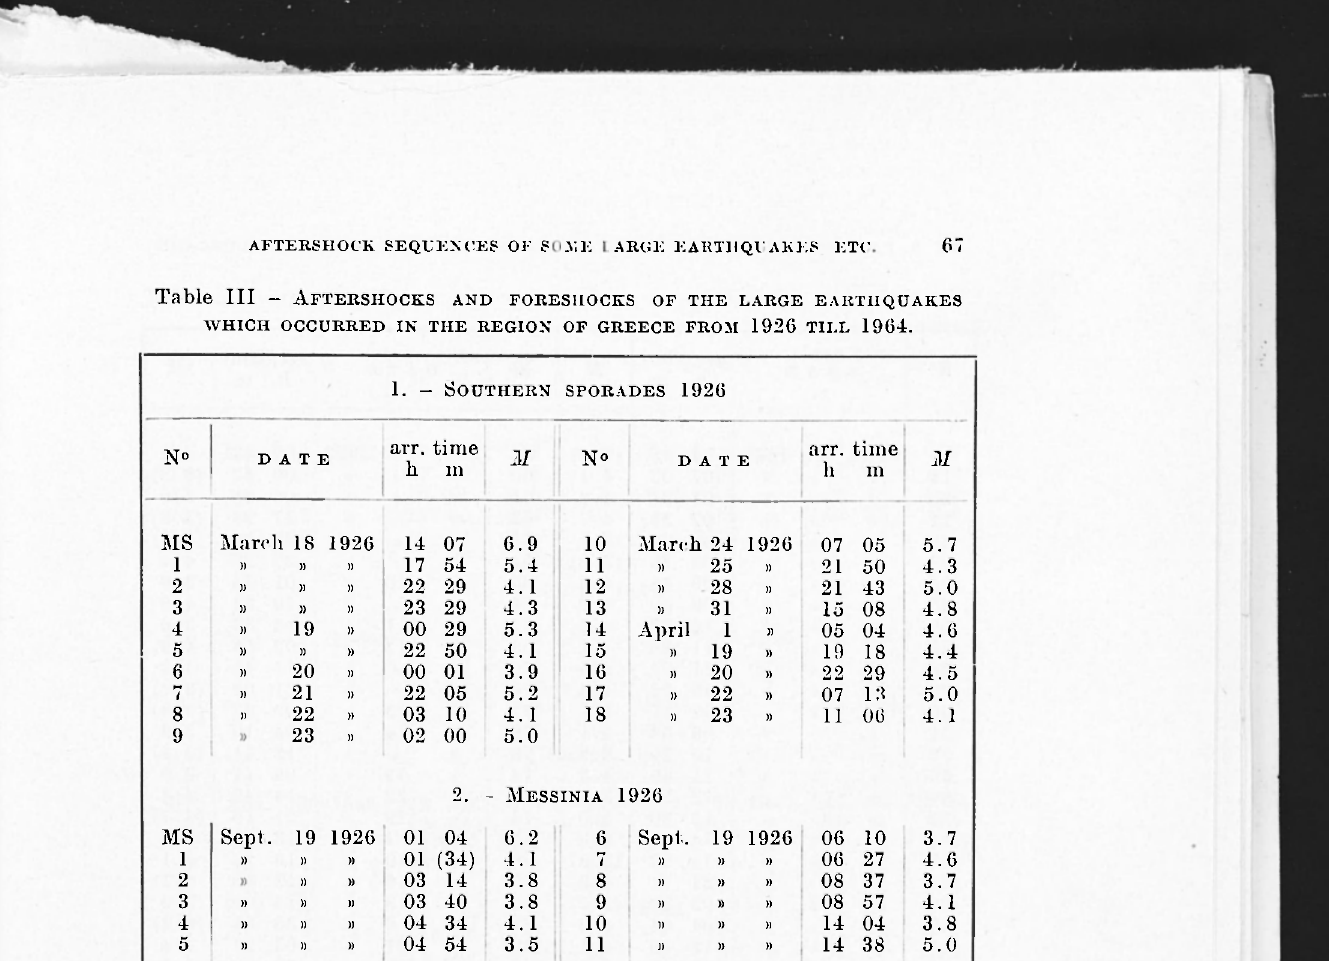
Table III - AFTERSHOCKS AND FORESILOCKS OF THE LARGE EARTHQUAKES WHICH OCCURRED IN THE REGION OF GREECE FROM 1926 TILL